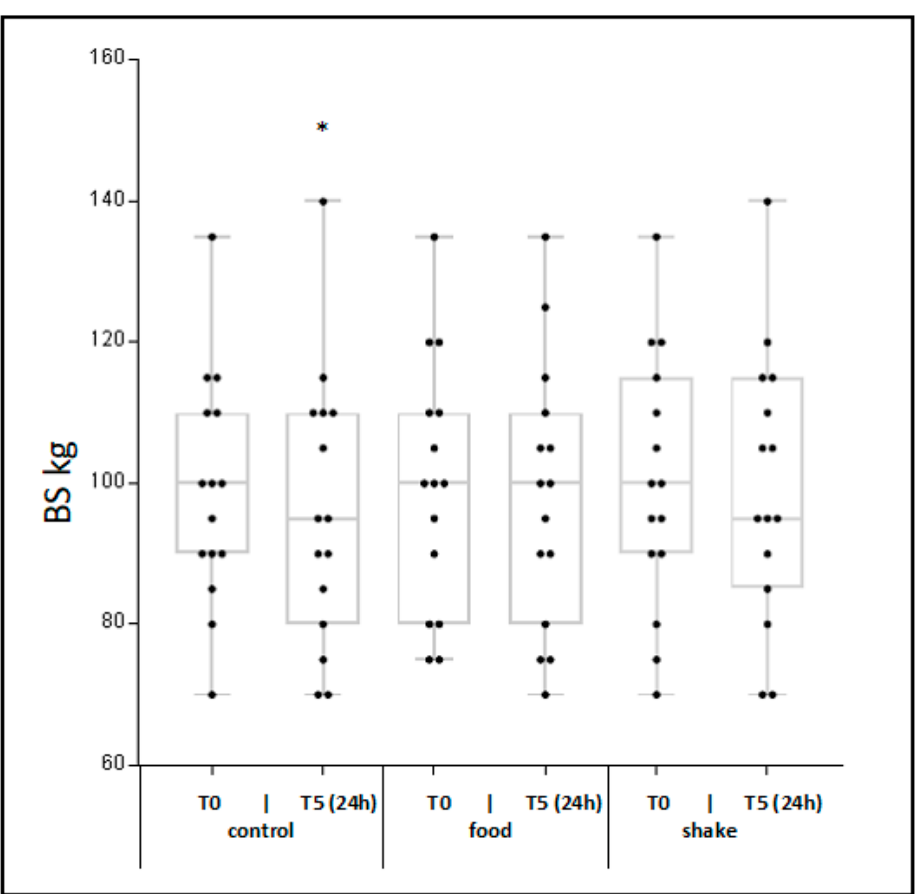
Figure 6. Effects of protein/carbohydrate uptake via food and shake on leg strength measured by the 3-repetition maximum back squat. In Figure 6 individual leg strength is shown Mean ± SD. * = p ≤ 0.01 show statistically significant differences between t5 and respective t0 value.